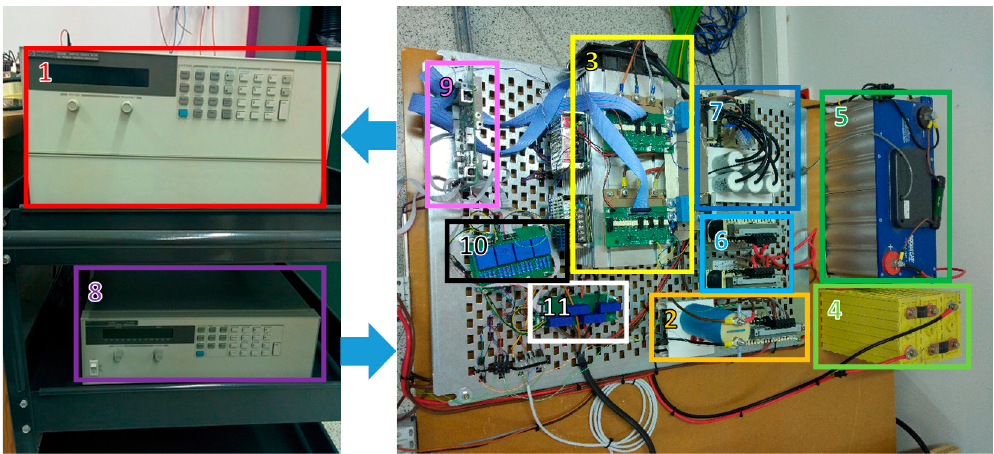
Figure 3. Picture of the prototype ((1) HP E4351B Solar Array Simulator, (2) Boost converter filter, (3) two Fuji IGBT-IPM 6MBP50RA120 power stage, (4) Li-ion batteries, (5) Maxwell BMOD0165 P048 B01 supercapacitor, (6) ESS converters filters, (7) inverter filter, (8) HP 6834B Power Source/Analyzer, (9) STM32F407 microcontroller based control board, (10) LV 25-P voltage sensors, (11) LA 55P/SP1 current sensors).